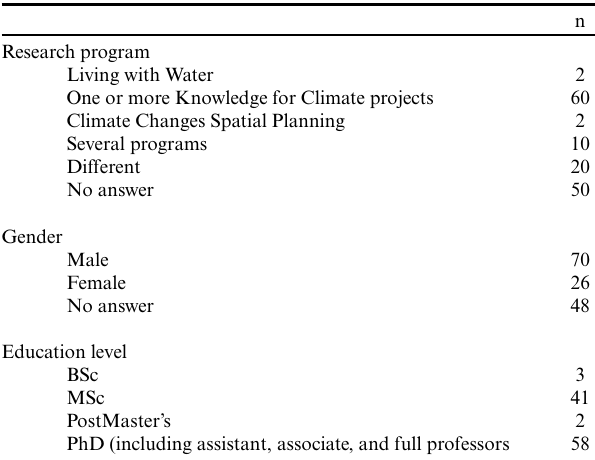
Table 1 . Key characteristics of the survey